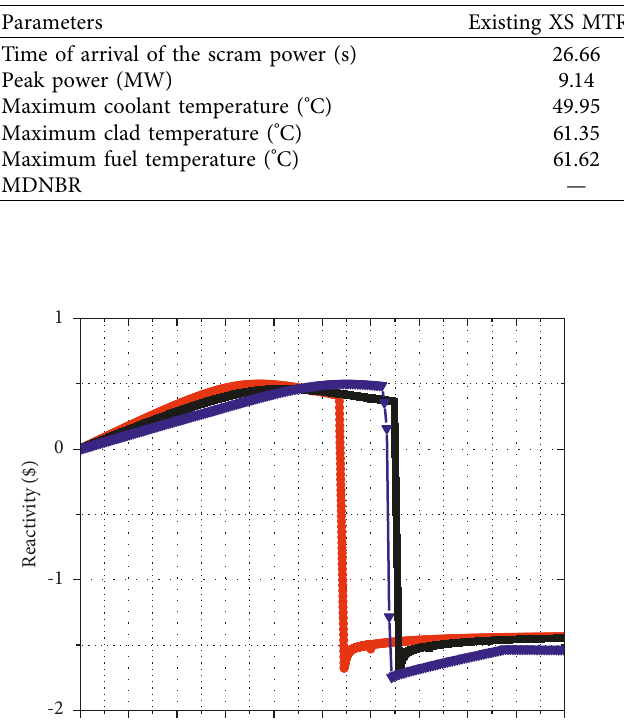
Table 3: Maximum temperature of the coolant, cladding, and fuel element during RIA transient at initial power 1W.